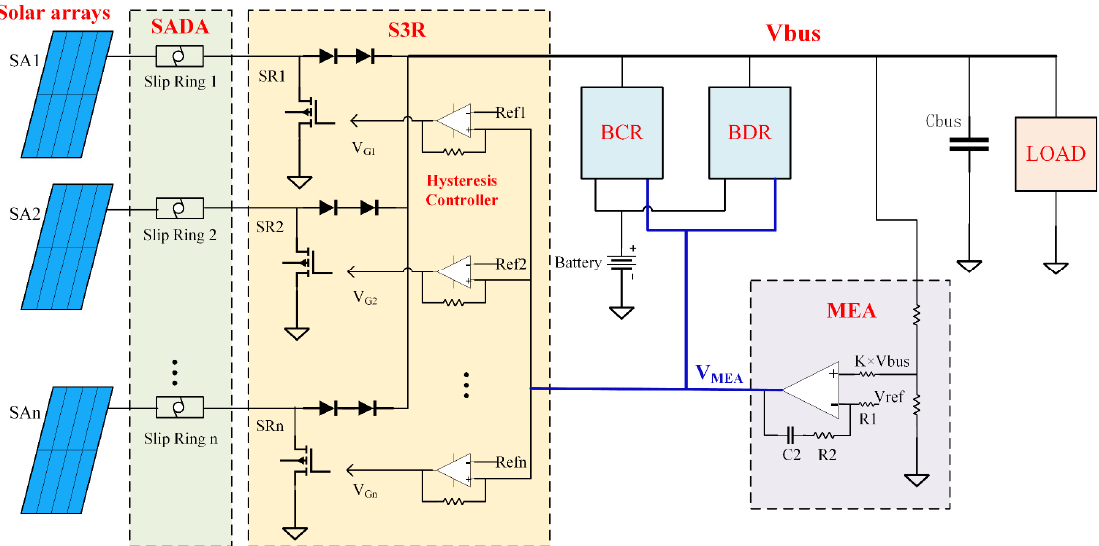
Figure 1. Schematic diagram of PCU.